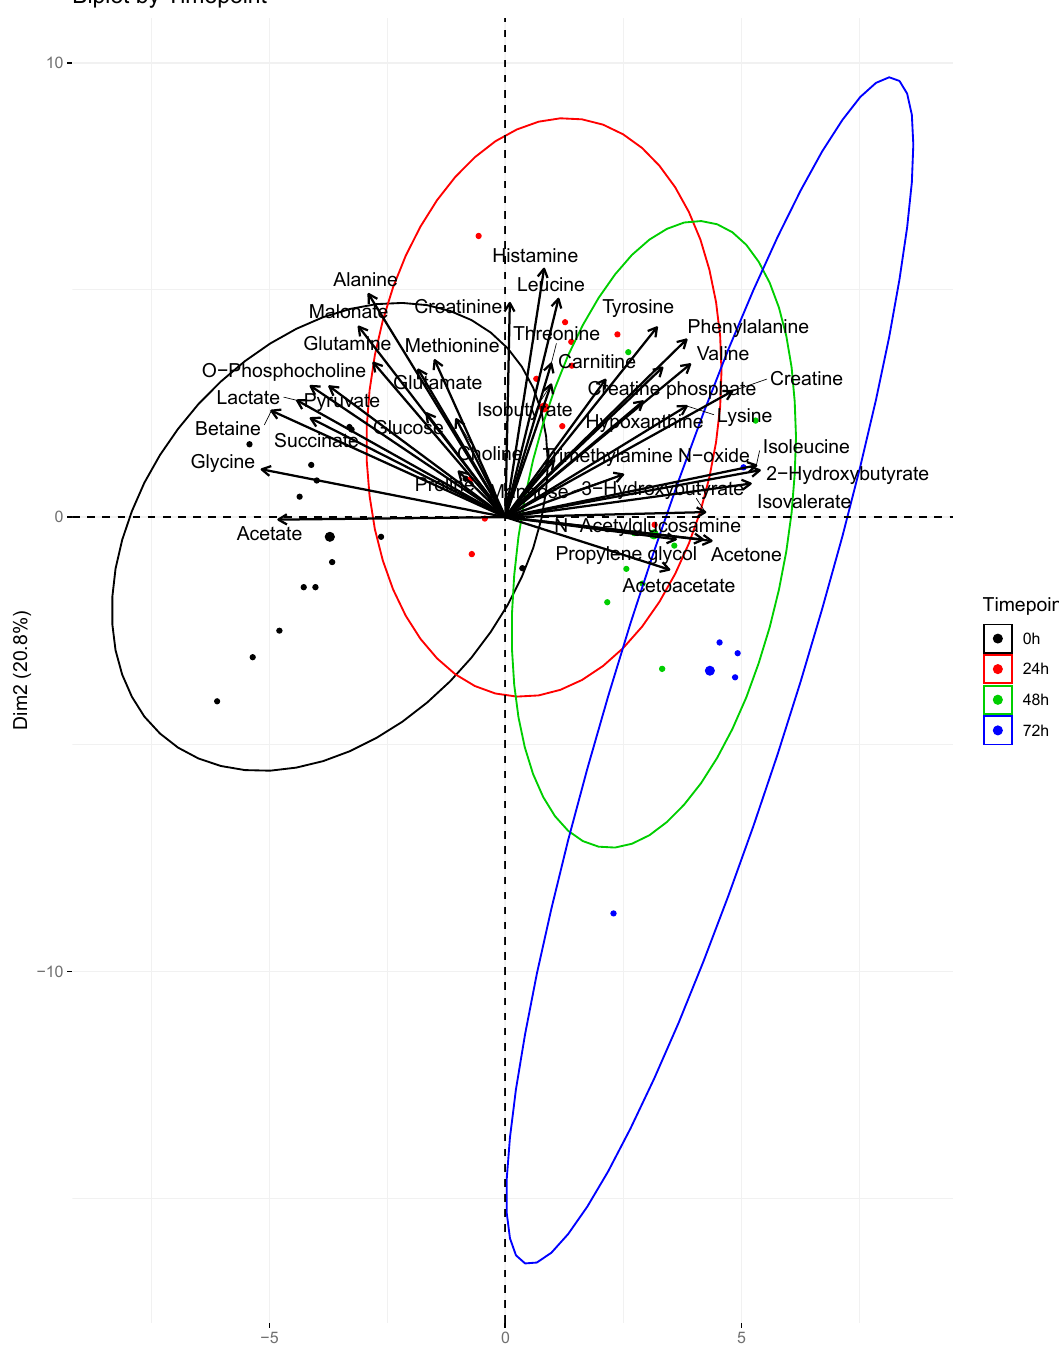
Figure 4. Principal component analysis biplot. Contributions of profiled metabolites were superimposed over scores for each serum sample. The direction and magnitude of the loadings vectors visually demonstrate how each metabolite contributes to sample clustering by timepoint. The larger dots represent the centroids of the ellipses calculated for each timepoint. At 0 h ( n = 15); 24 h ( n = 11); 48 h ( n = 8); 72 h ( n = 5).